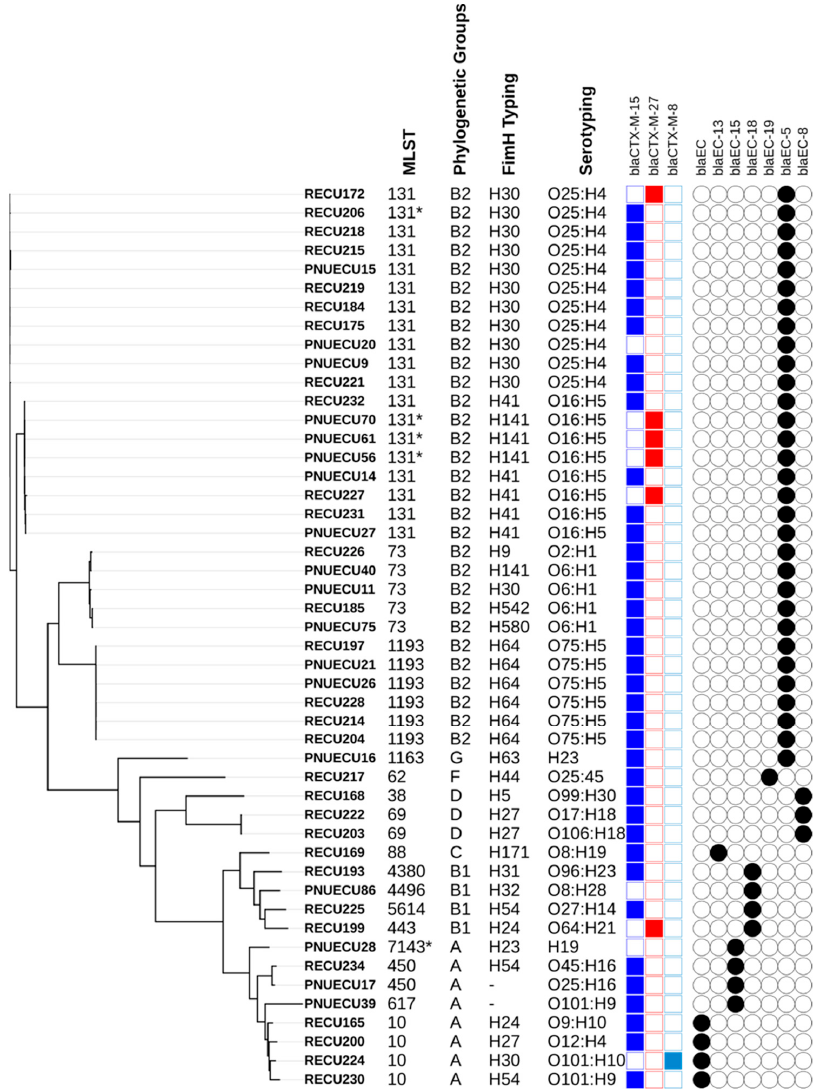
Figure 1. SNP-derived phylogenetic tree of the UPEC ESBL strains in this study, compared with MLST, phylogenetic groups, fi mH typing, serotyping, and ESBL resistance genes. * Isolates displaying a single-locus variant (SLV).